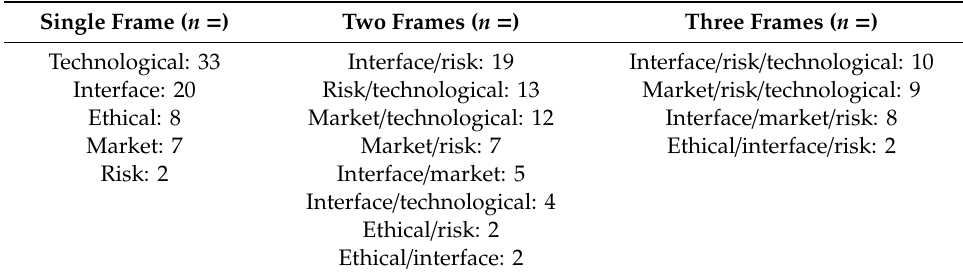
Table 2. Correlations between frames in CIS literature ( n =